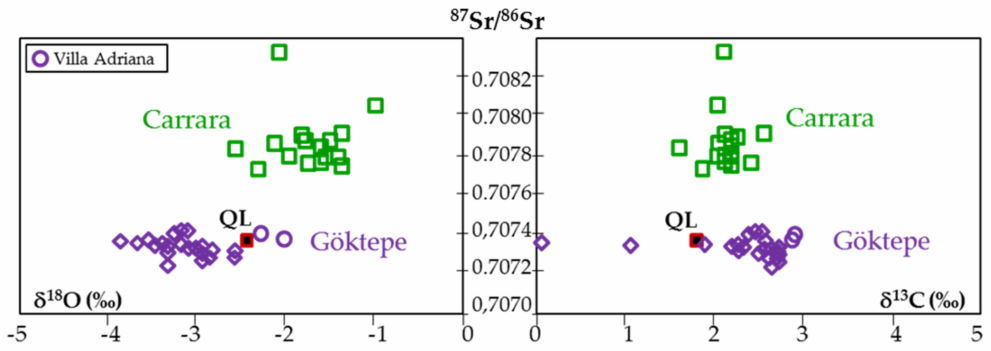
Figure 13. Plots of Sr isotope composition vs. δ 18 O and δ 13 C obtained in the QL sample (red and black square), based on the diagrams proposed in [17], allowing for unequivocal discrimination between Göktepe and Carrara white marble, both quarry samples and artefacts from Villa